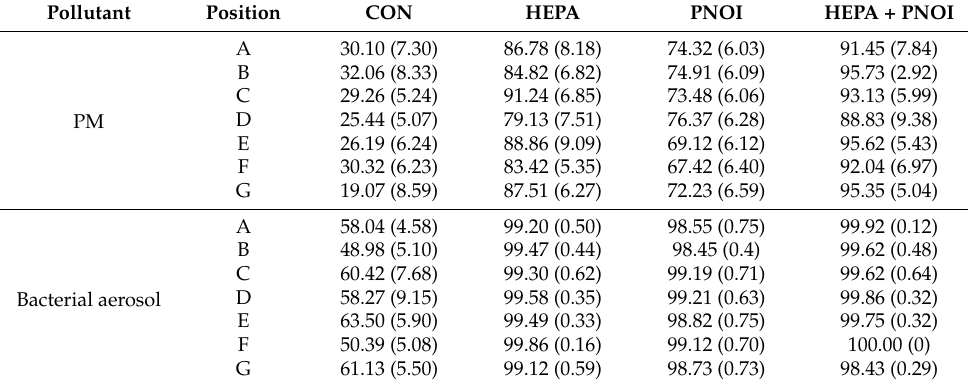
Table 3. PM and aerosol purification rates at 7 positions (%, mean (SD)).